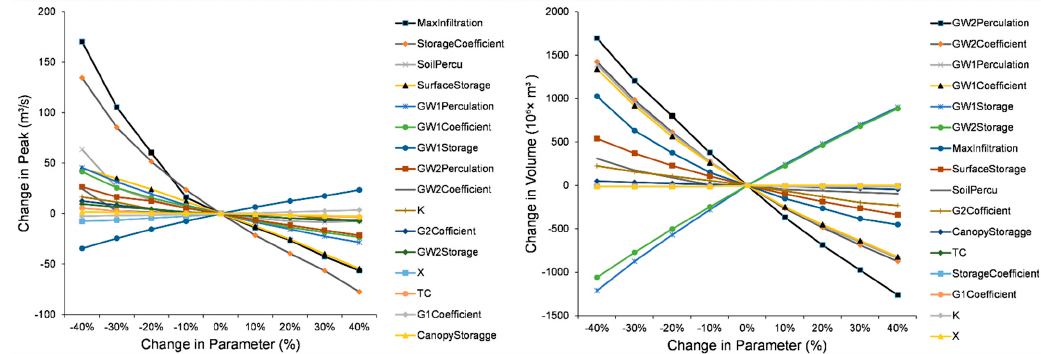
Figure 5. Changes in peak and volume with respect to the changes in parameters.